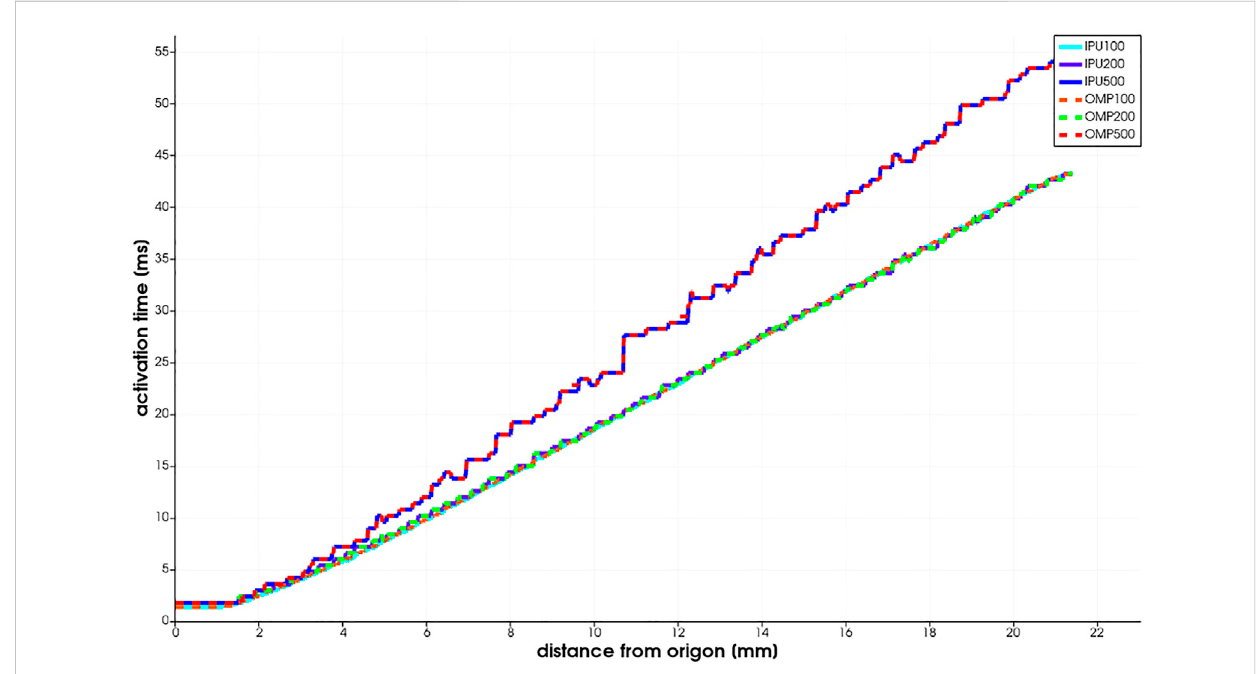
FIGURE 3 Niederer benchmark results reported as the activation time vs. the distance from the stimulus